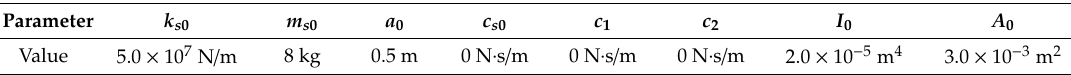
Table 1. The parameters of homogeneous straight damping beam and spring-mass oscillator in the calculation example, the subscript 0 is defined to distinguish the calculation example and parametric